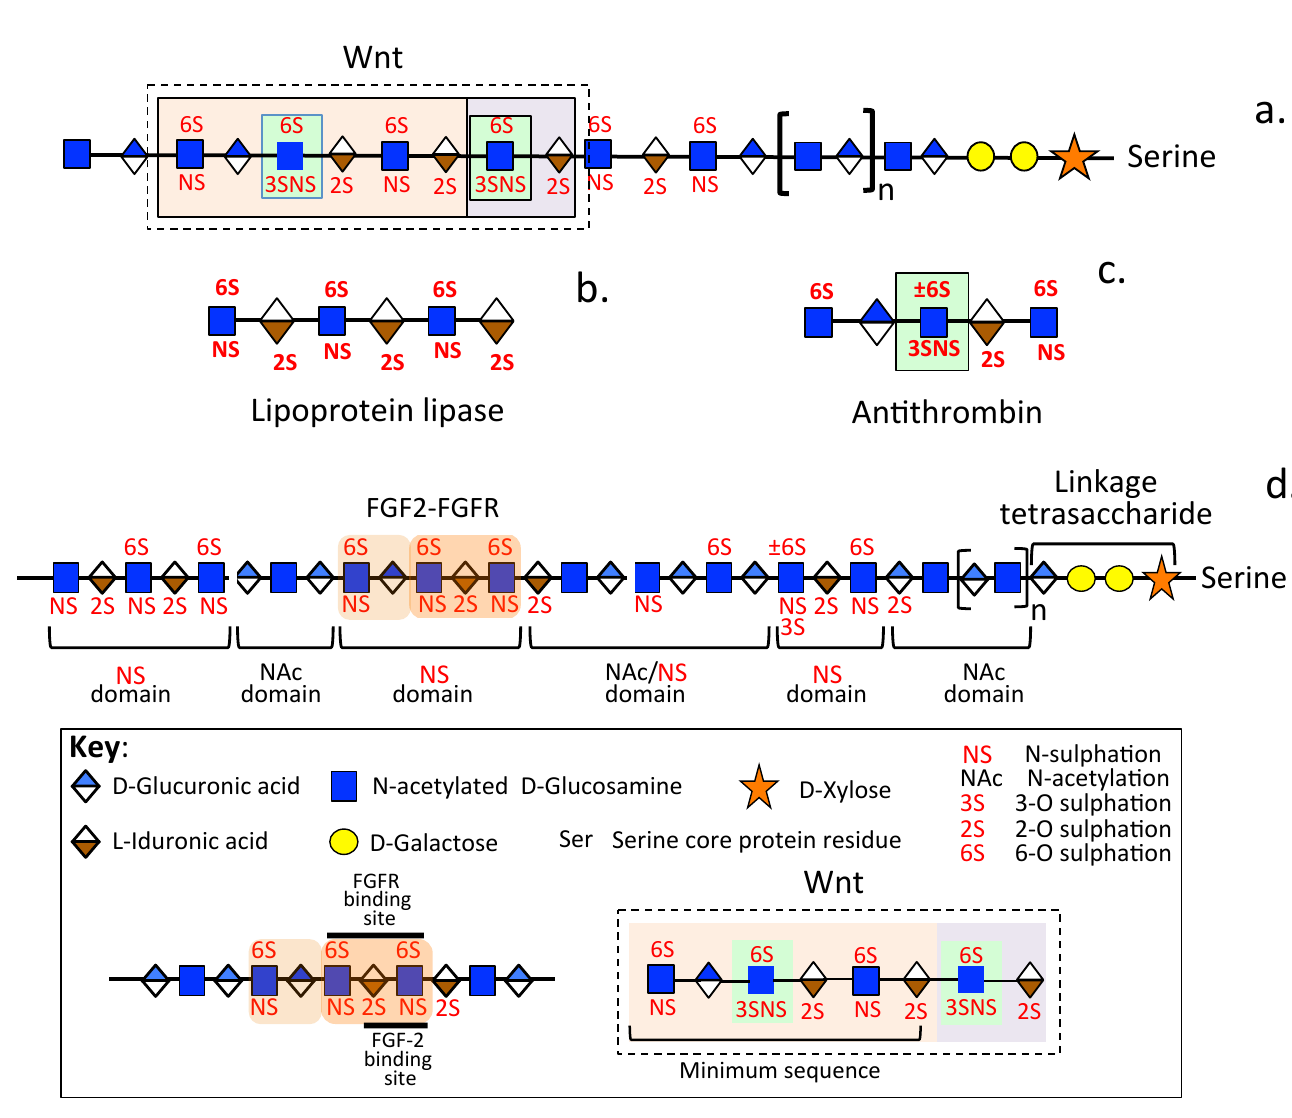
Figure 4. Identification of specific ligand interactive glyco-sequences in HS. The structures Figure 1. Schema/c depic/on of the domain organisa/on of a hypothe/cal HS chain showing the FGF-2 and FGFR binding domain. shown are those proposed by Gao et al. [188] ( a ) Cummings [210] ( b , c ) and Gomes et al. [211]; Wang et al. [212] ( d ). The orange highlighted area in HS in ( d ) depicts FGF-2 and FGF-R binding sites however flanking structures also contribute to specificity in a functional tetra or pentasaccharide arrangement as determined by NMR spectroscopy